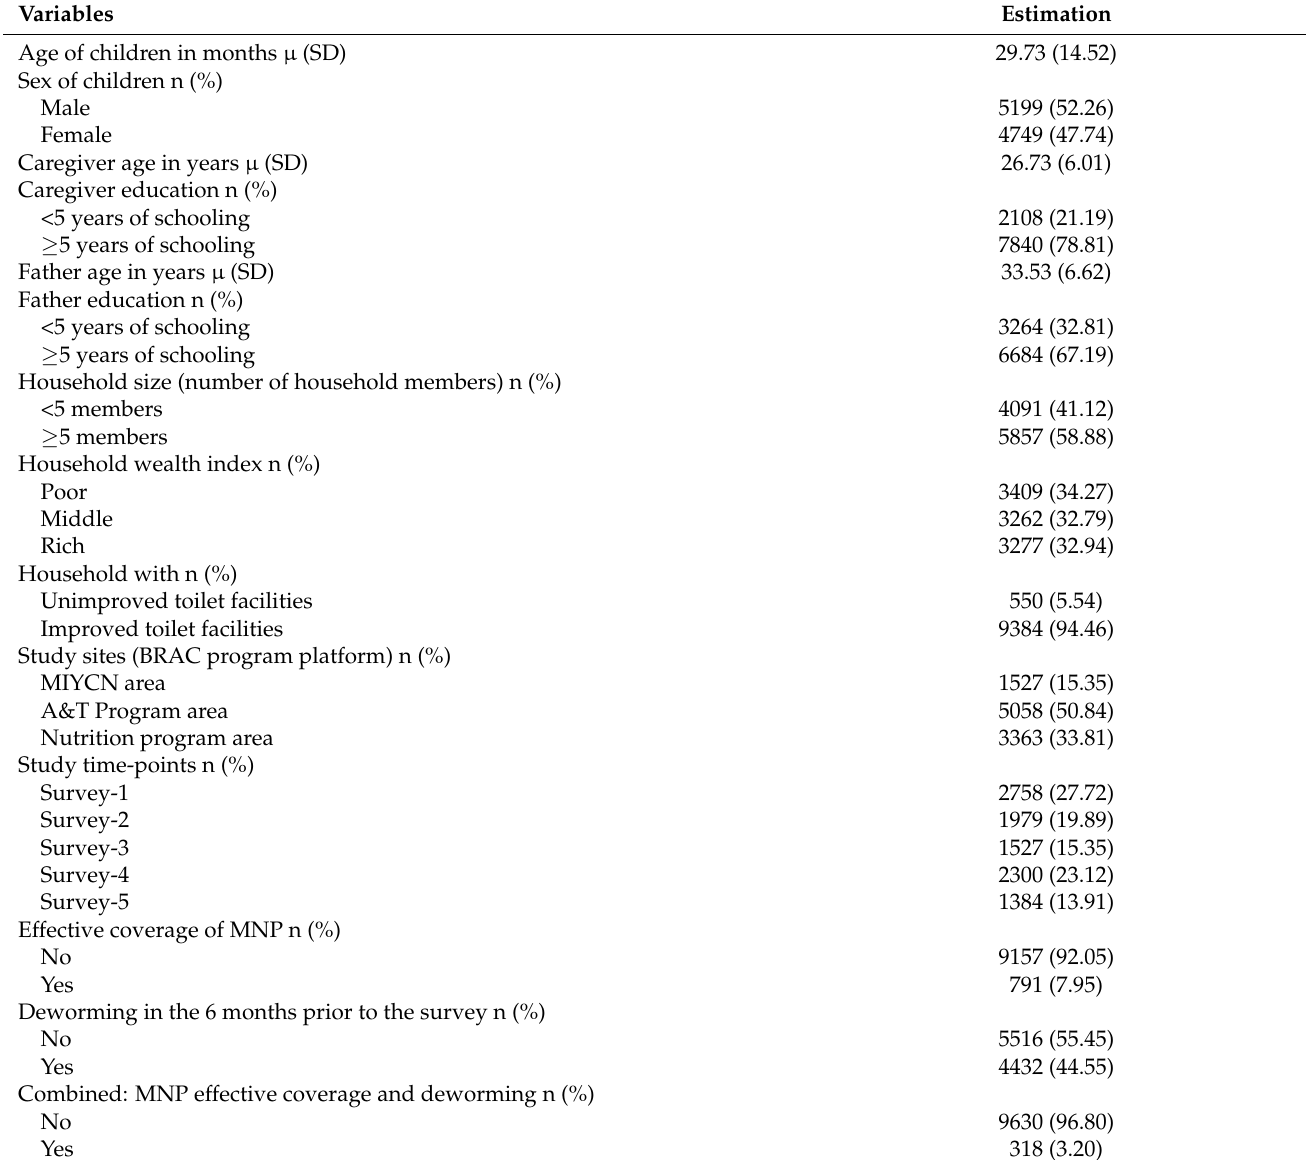
Table 1. Background characteristics of study participants.